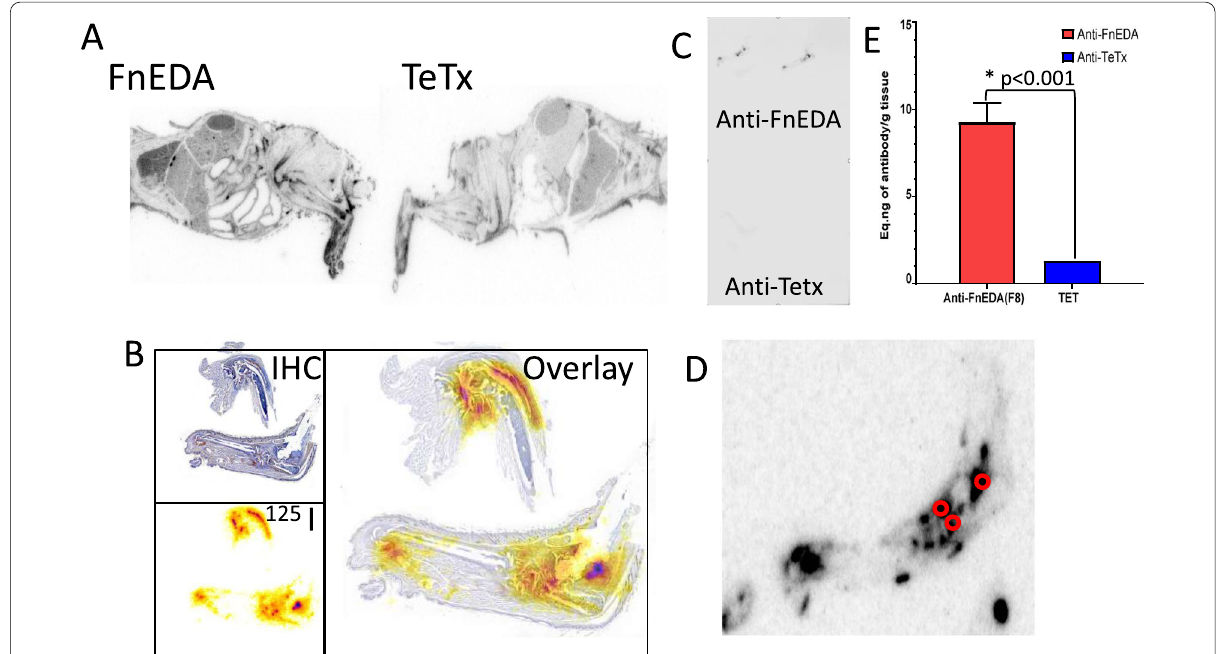
Fig. 5 Whole body autoradiography in mCIA model. Comparison of mCIA mice dosed with 125 I labeled anti-FnEDA (left) and control 125 I labeled anti-TeTx mAb (right) ( A ). IHC detection of anti-FnEDA mAbs overlaid with the radio signal ( B ). Representative paws from animals dosed with Anti-FnEDA or Anti-TeTx ( C ). For each paw, 3 circles with identical area were drawn over high intensity areas ( D ), and the radioactive signal from these circles were converted to amount of antibody based on a standard curve and plotted ( E ). (Red bar represents the average amount of antibody extrapolated from such areas in joints of mice treated with anti-FnEDA mAb with standard deviation, N of antibody extrapolated from such areas in joints of mice treated with anti-TeTx mAb with standard deviation, N